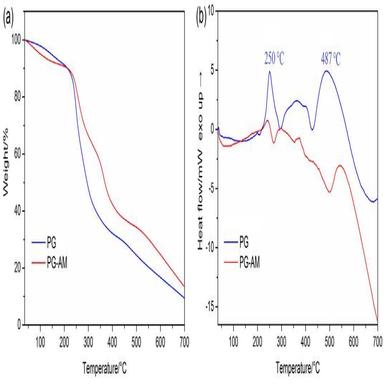
TGA curves (a) and DSC curves (b) for PG and PG-AM.